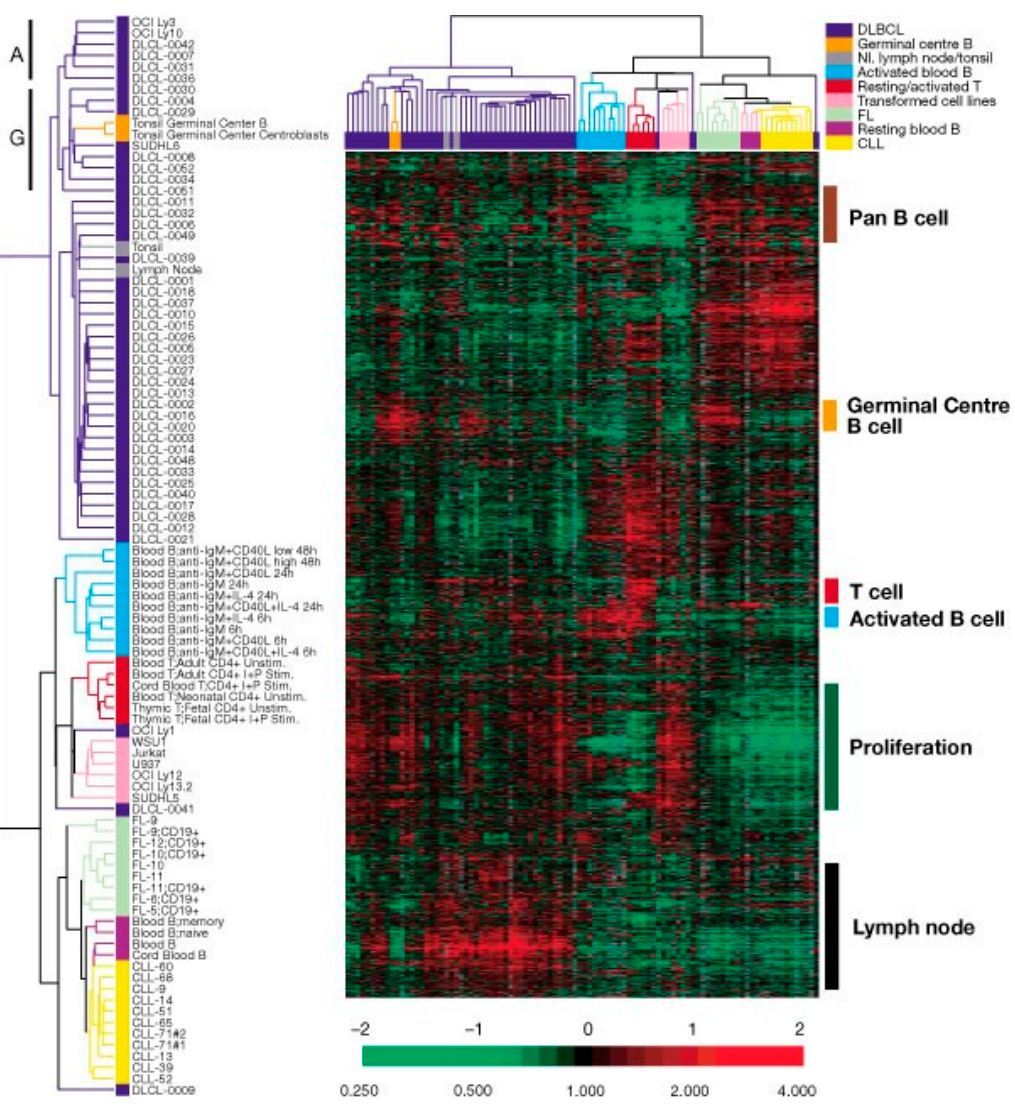
Figure 1. Hierarchical clustering of GEP data. Different lymphoid malignancies form distinct clusters based on their gene expression profile. Reproduced from Figure 1: Alizadeh AA et al. Nature volume 403, pages 503–511 (2000).